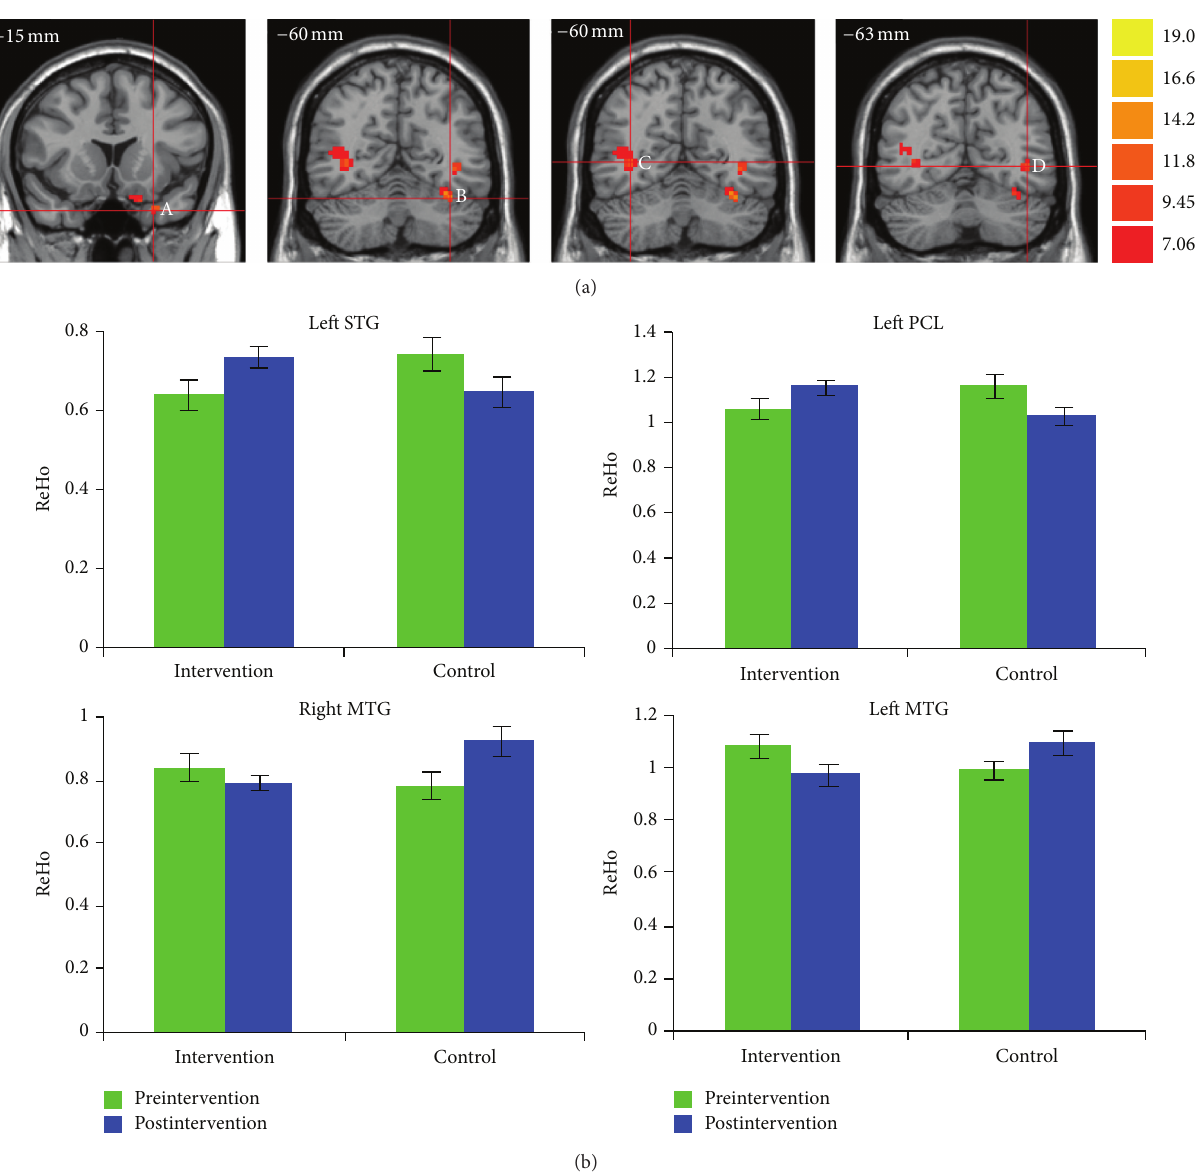
Figure 3: Combined cognitive-psychological-physical intervention altered the ReHo of spontaneous brain activity in the left STG, left PCL, and bilateral MTG. (a) Coronal view of brain regions showing significant Group × Intervention interactions in ReHo for (A) left STG; (B) left PCL; (C) right MTG; (D) left MTG. The numbers above each image refer to the 𝑦 plane coordinates of MNI. Left in picture is right in the brain. (b) Bar plots showing the mean ReHo of spontaneous brain activity in these ROIs before and after intervention, for the intervention and control